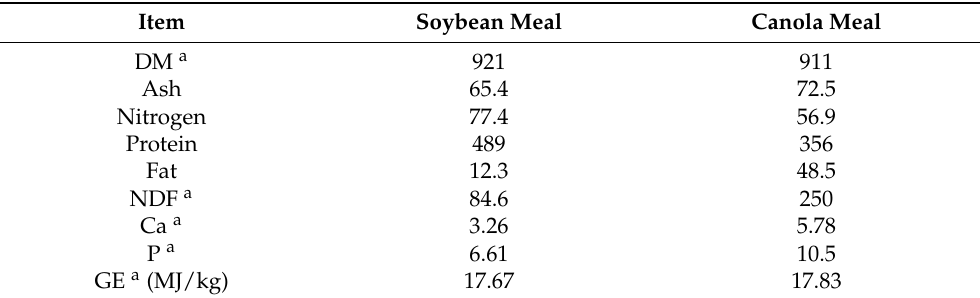
Table 1. Proximate, carbohydrate and mineral composition of the tested protein sources (g/kg; as received